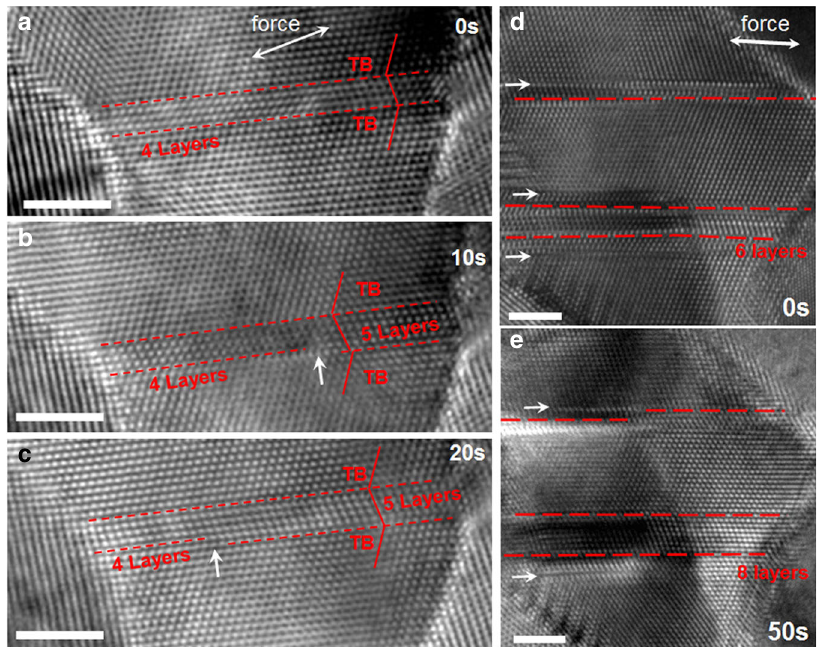
Fig. 3 In situ observation of partial dislocation emissions both from GB-TB intersection and conventional GBs in a relatively thin twin/matrix. a – c Partial dislocations are emitted from the GB-TB intersection and glide on the TB, leading to TB migration and formation of a step on the TB. d The initial twin/matrix with 6 atomic layers in a grain. e An 8 atomic layered twin/matrix was formed. The arrowed SFs are caused by partial dislocation emission from the GBs. The scale bars are for 2 nm.